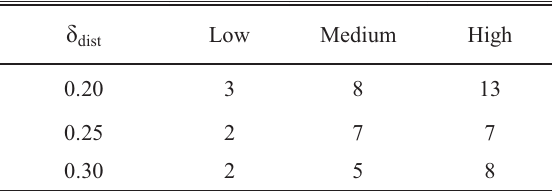
Table 4. The center number of each network